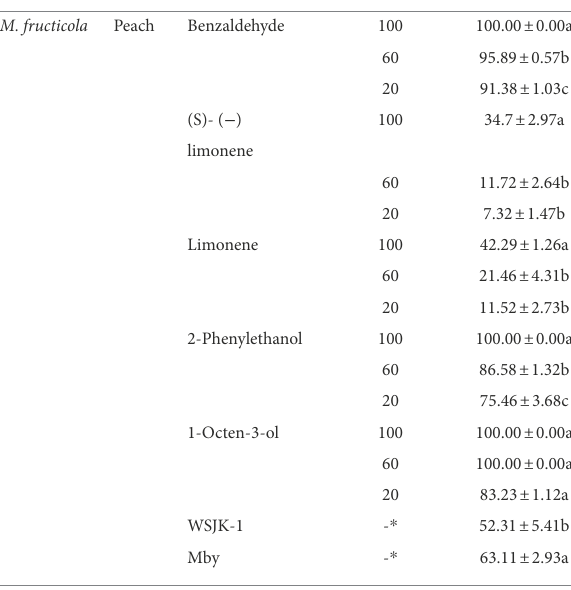
TABLE 6 Inhibition of C. fimbriata and pure VOCs against fungal postharvest pathogens inoculated on Peaches in vivo . Pathogens Fruits Compounds Concentration ( μ l L − 1 )